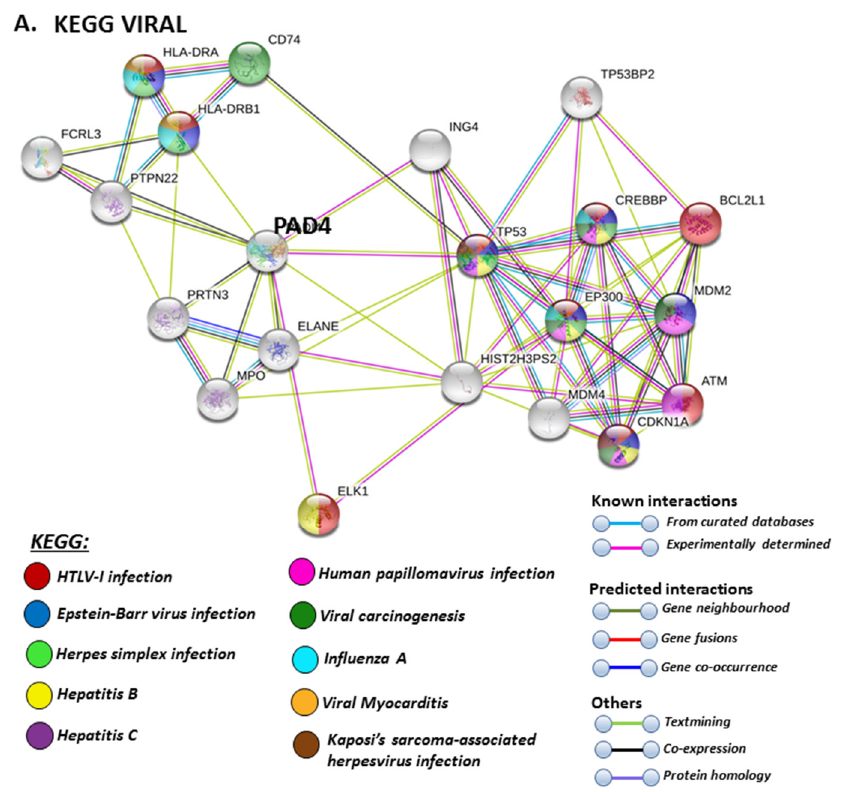
Figure 7. GO and Reactome pathway analysis for PAD3, highlighting GO biological pathways ( A ) Reactome pathways, UniProt keywords and PFAM protein domains ( B ) Colour code for the different pathways is shown within the figure. Individual coloured lines represent specific